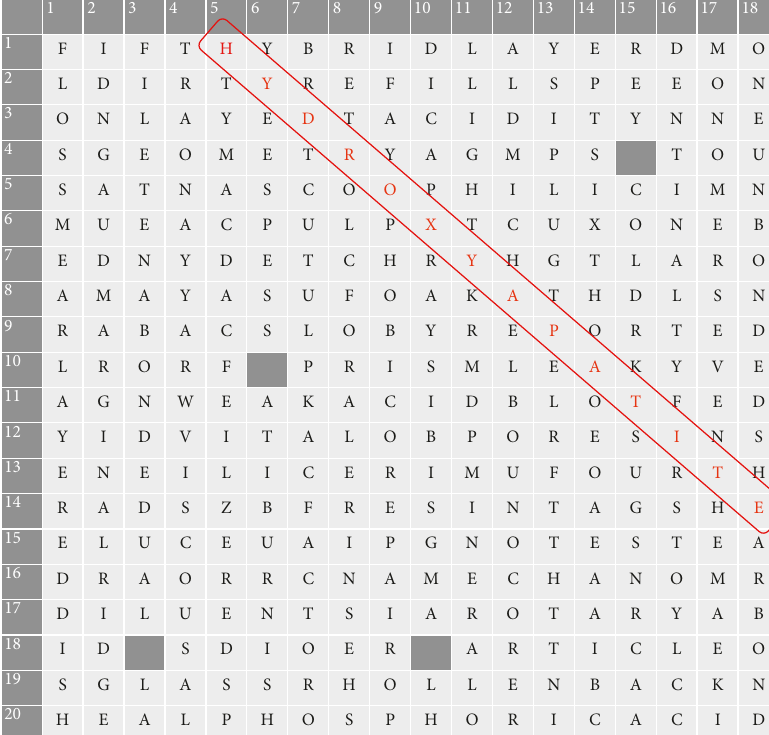
Figure 2: For additional competitiveness, each puzzle contained a hidden diagonal word that must be identified in order to complete the challenge. In this example, the hidden word is